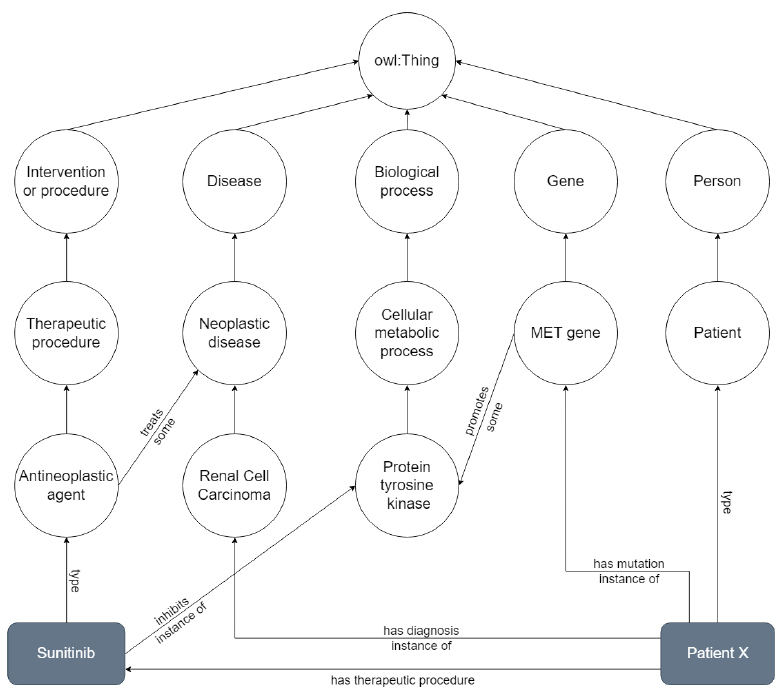
Figure 1. Knowledge graph representing a smaller network that includes renal cell carcinoma, MET gene, antineoplastic agent and proten tyrosine kinase, with instances of a Patient X and the drug Sunitinib. All concepts are derived from the class owl:Thing. Adapted from the